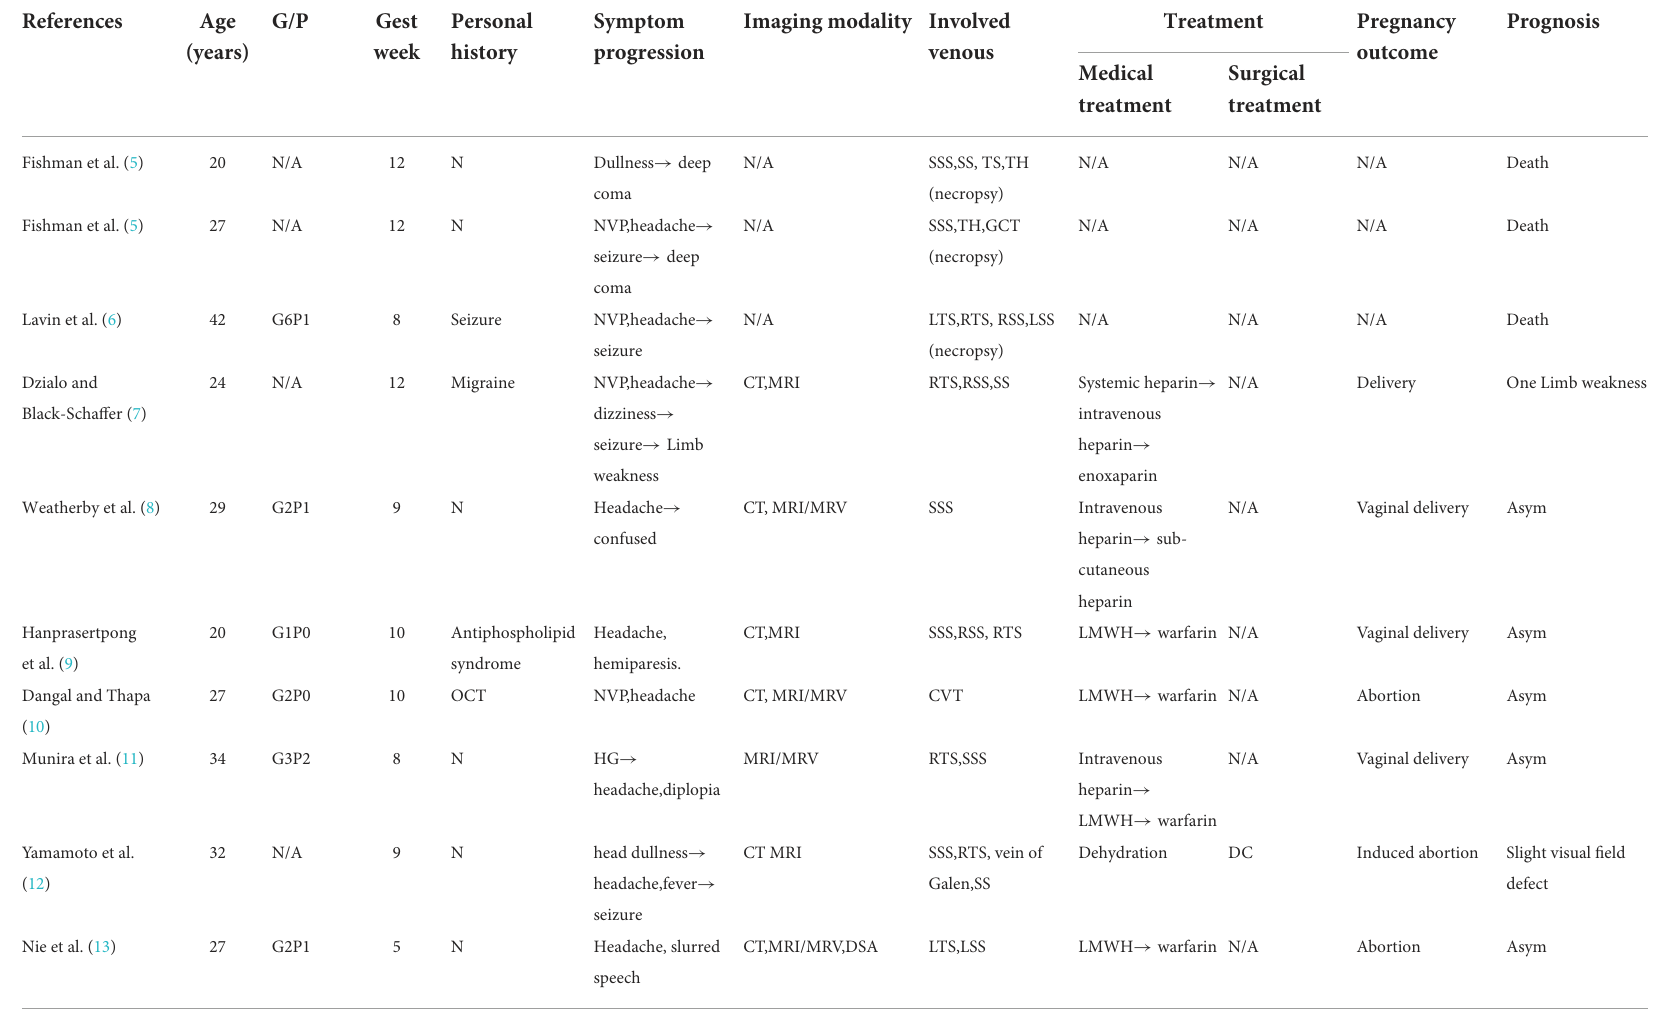
TABLE 5 Clinical characteristics and outcome of the 15 included patients with CVT in published